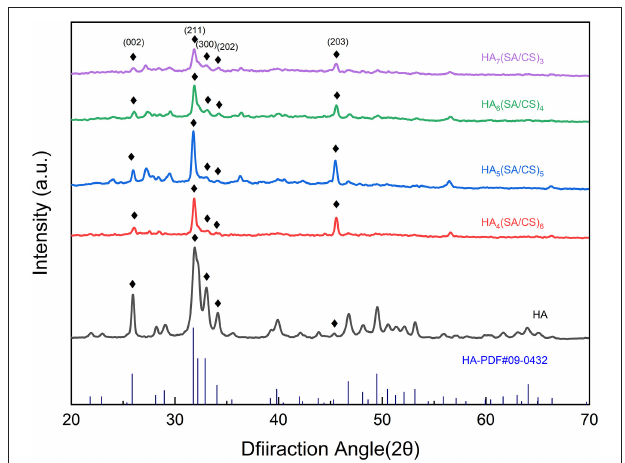
FIGURE 2 | XRD spectrum of HA, HA 7 (SA/CS) 3 scaffold, HA 6 (SA/CS) 4 scaffold, HA 5 (SA/CS) 5 scaffold, and HA 4 (SA/CS) 6